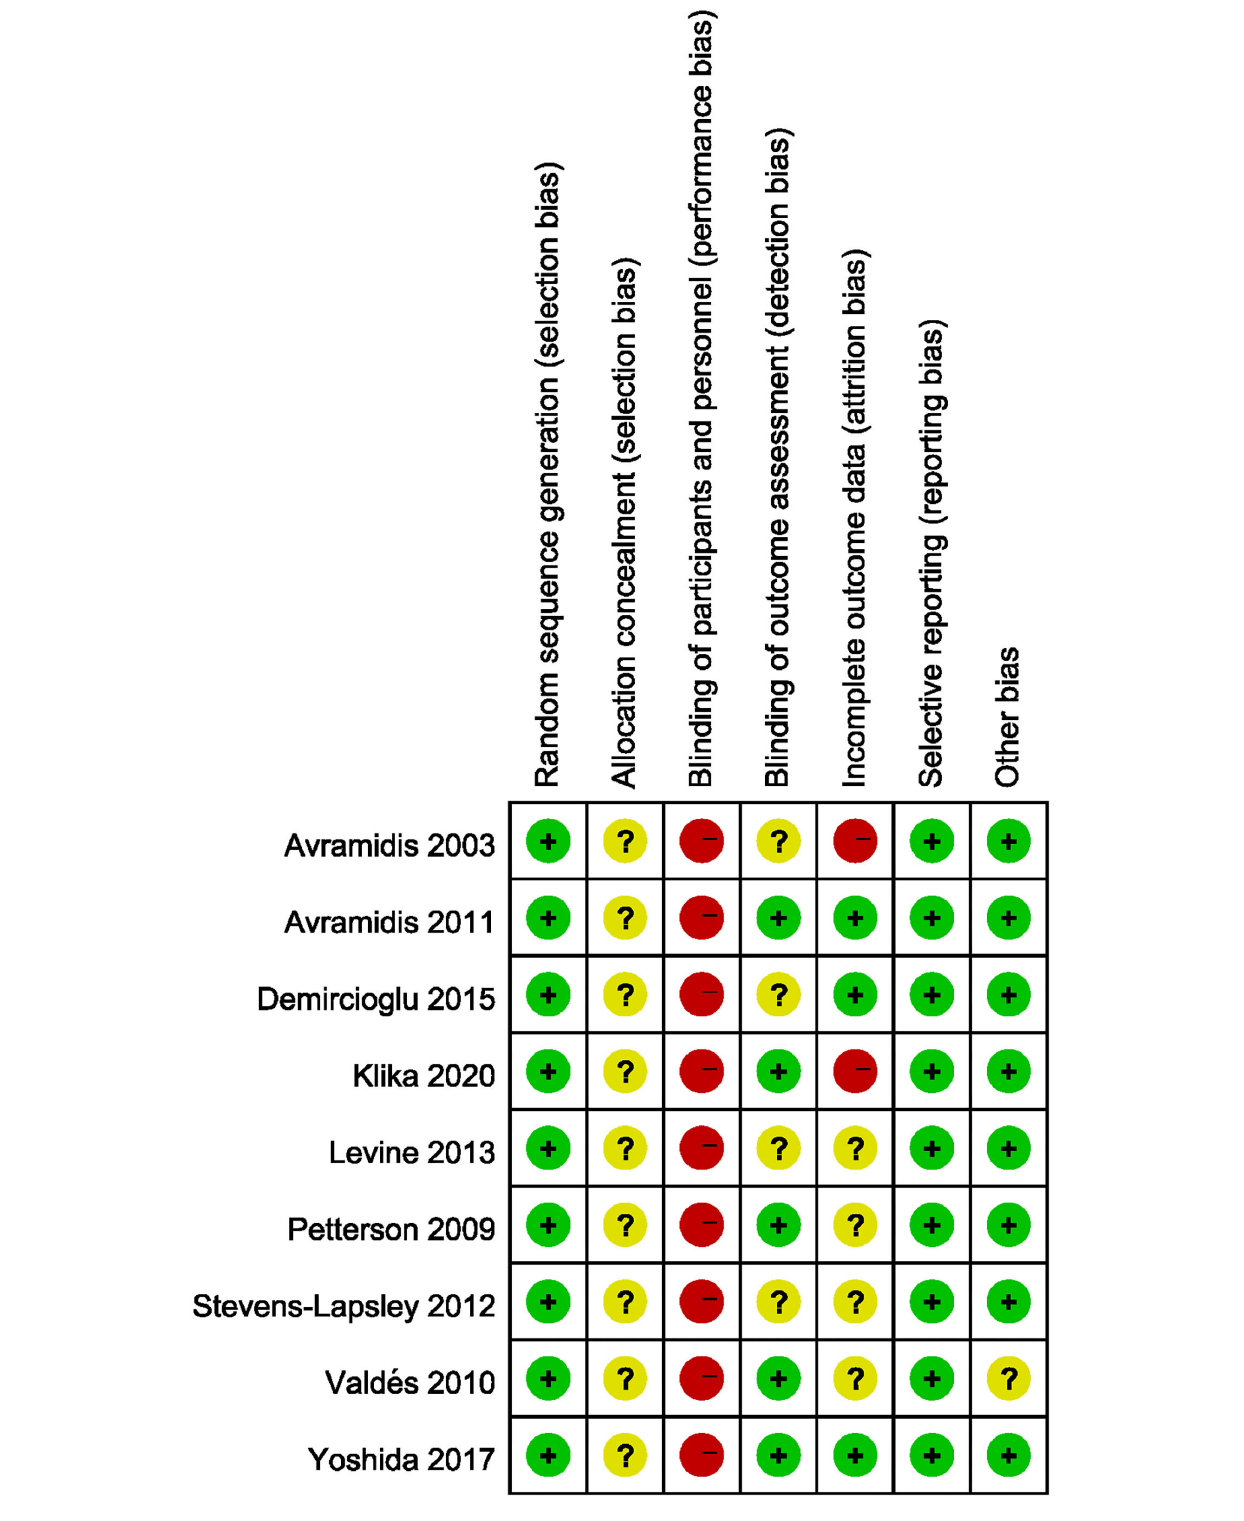
Frontiers in Medicine |